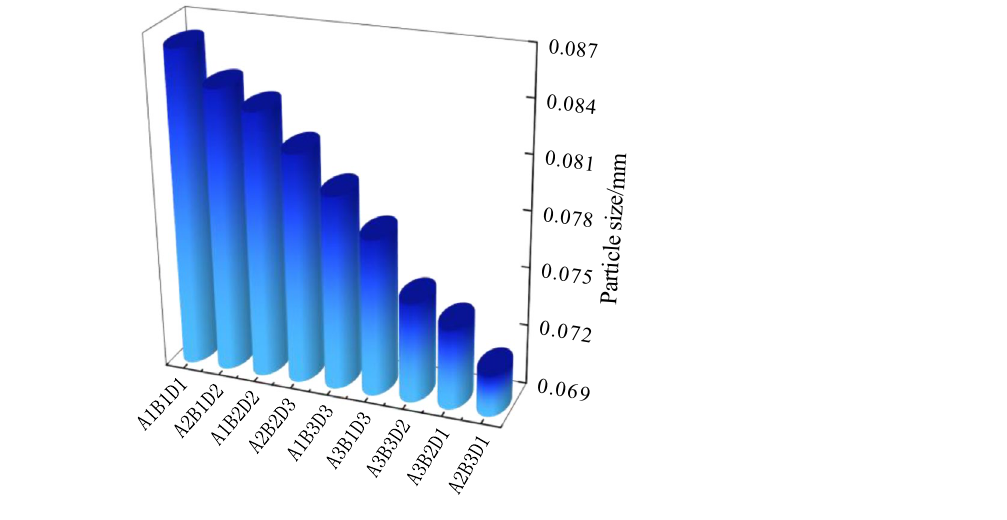
Figure 18. Graph of particle size versus fractality.